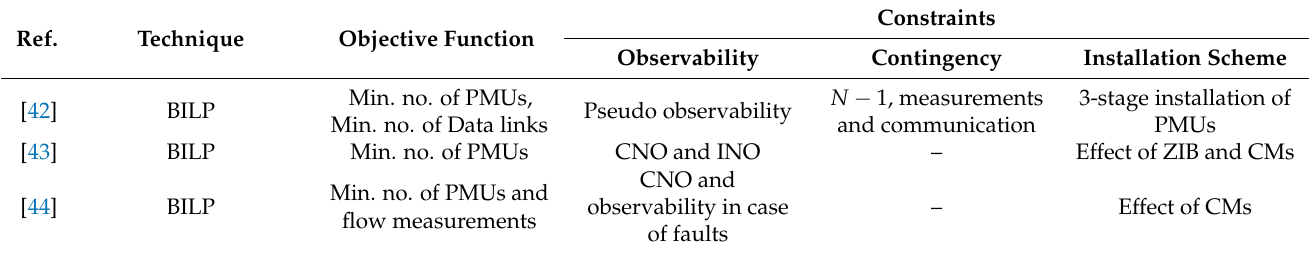
Table 2. A summary of LP based